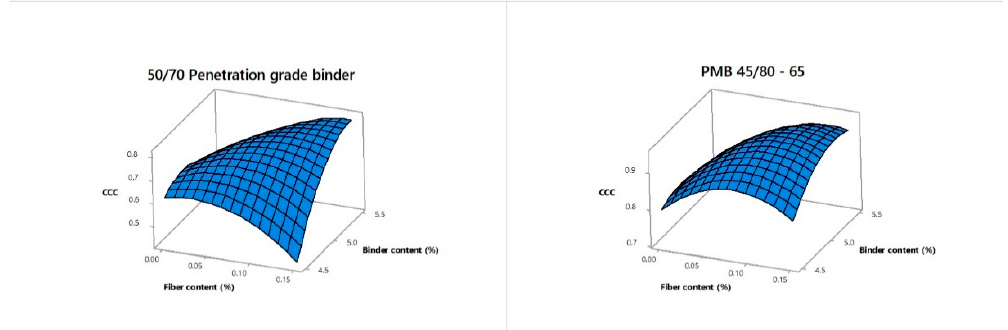
Figure 12. Interaction effect of fiber content and binder content as a function of the CCC score value for a 50/70 penetration grade binder (left) and a PMB 45/80-65 (right).